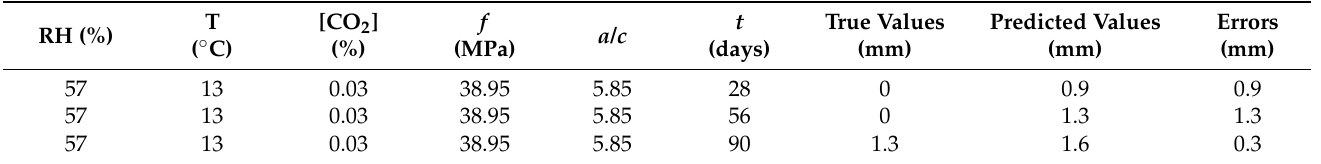
Table 6. Natural carbonation dataset and predicted values